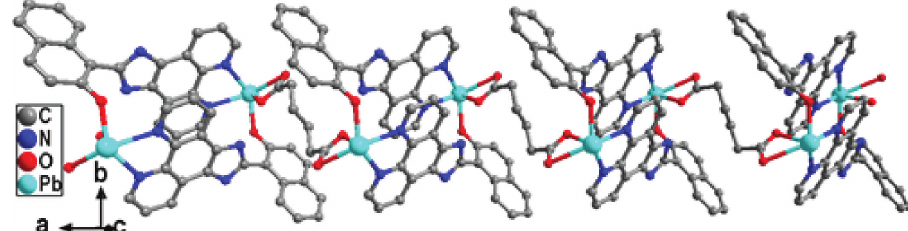
Figure 2: View of the 1D chain structure of 1 .